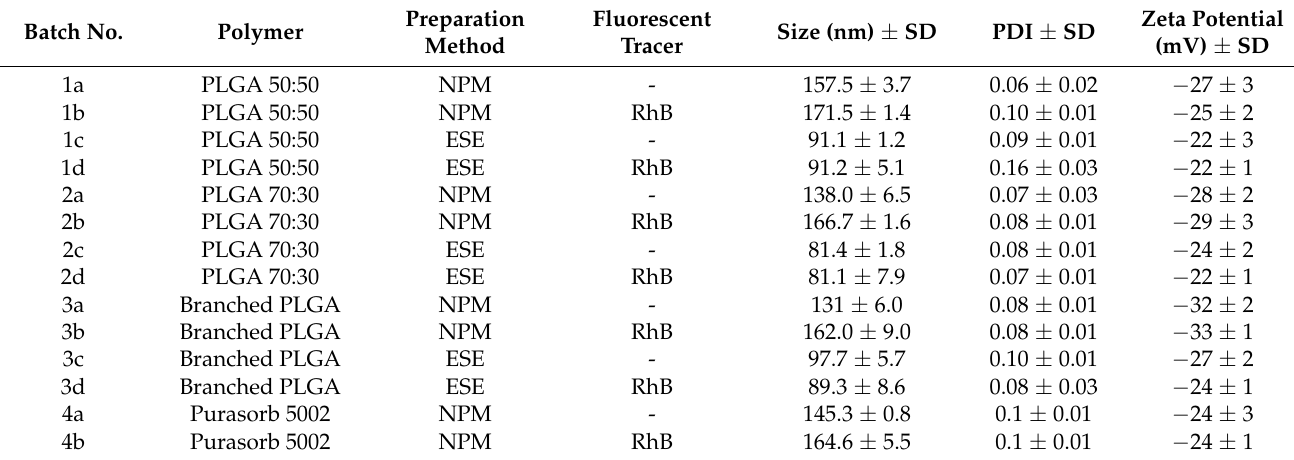
Table 1. Characteristics of PLGA nanospheres used in the study prepared by the nanoprecipitation (NPM) and the emulsification solvent evaporation (ESE) methods. Batch